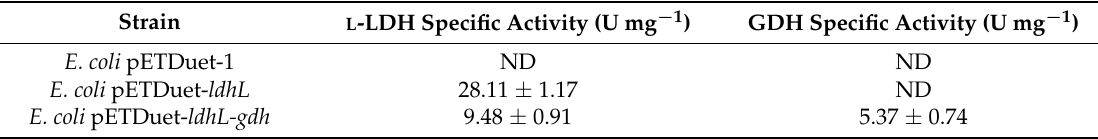
Table 1. Specific activity of L -LDH and GDH of recombinant strains.